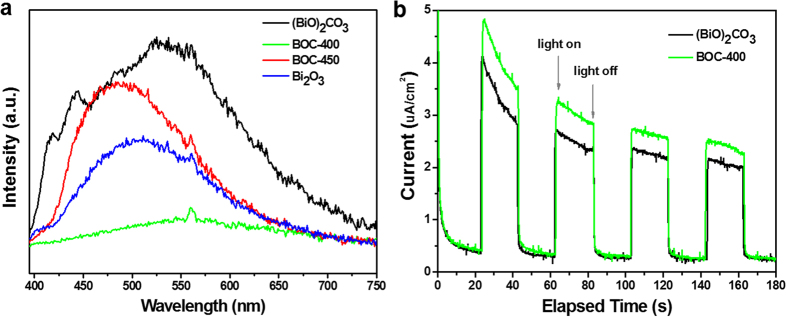
(a) Room-temperature PL spectra of the as-prepared samples. (b) Photocurrent plot of (BiO)2CO3 and BOC-400 photoeletrodes.